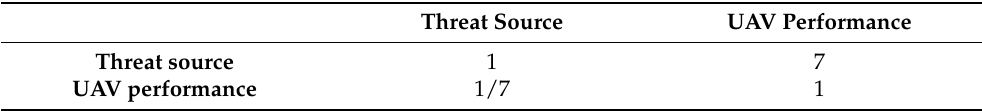
Table 10. Judgmental matrixes of AHP criteria hierarchy of mission point.